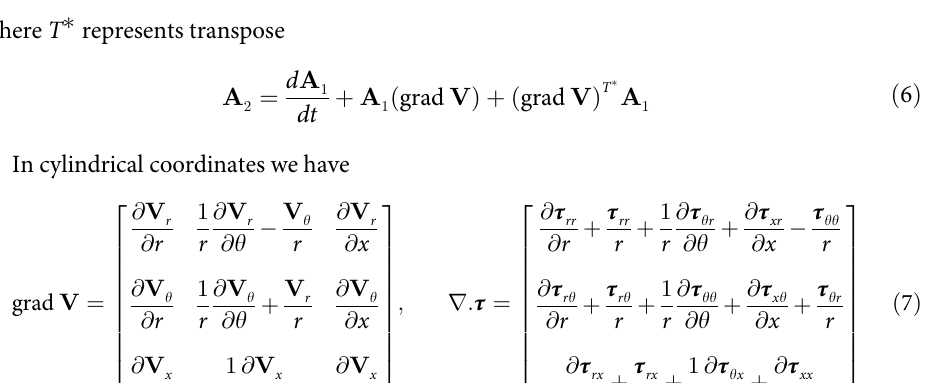
Fig 1. Physical model.